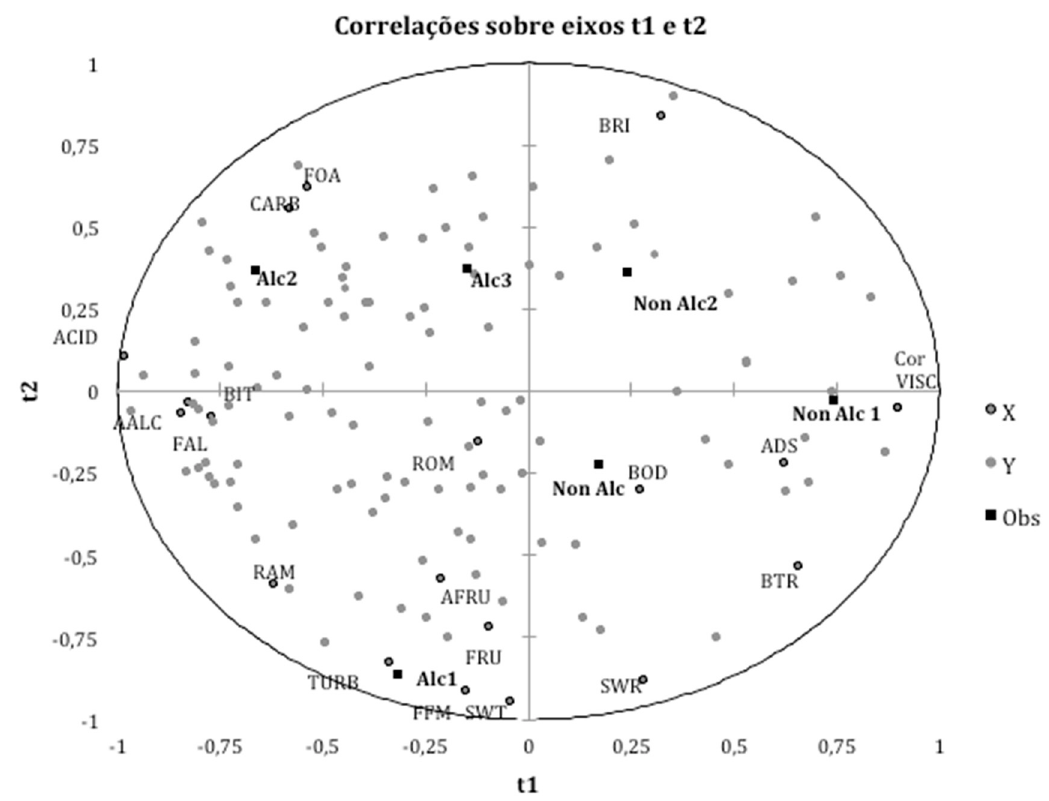
Figure 2. External preference map determined by multiple regression analysis by partial least squares between global impression averages and terms descriptors determined in the QDA (X: Attributes, Y: Consumers and Obs: Samples). Abreviations = Yellow Color (COR); Foam Presence (FOA); Brightness (BRI); Turibidity (TURB); Alcoholich Aroma (AALC); Raw Malt Aroma(RAM); Roasted Malt Aroma